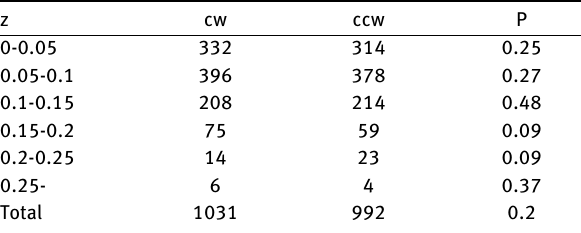
Table 15. The distribution of clockwise and counterclockwise galax- ies in different z ranges in the RA range (30 ∘ , 120 ∘ ).